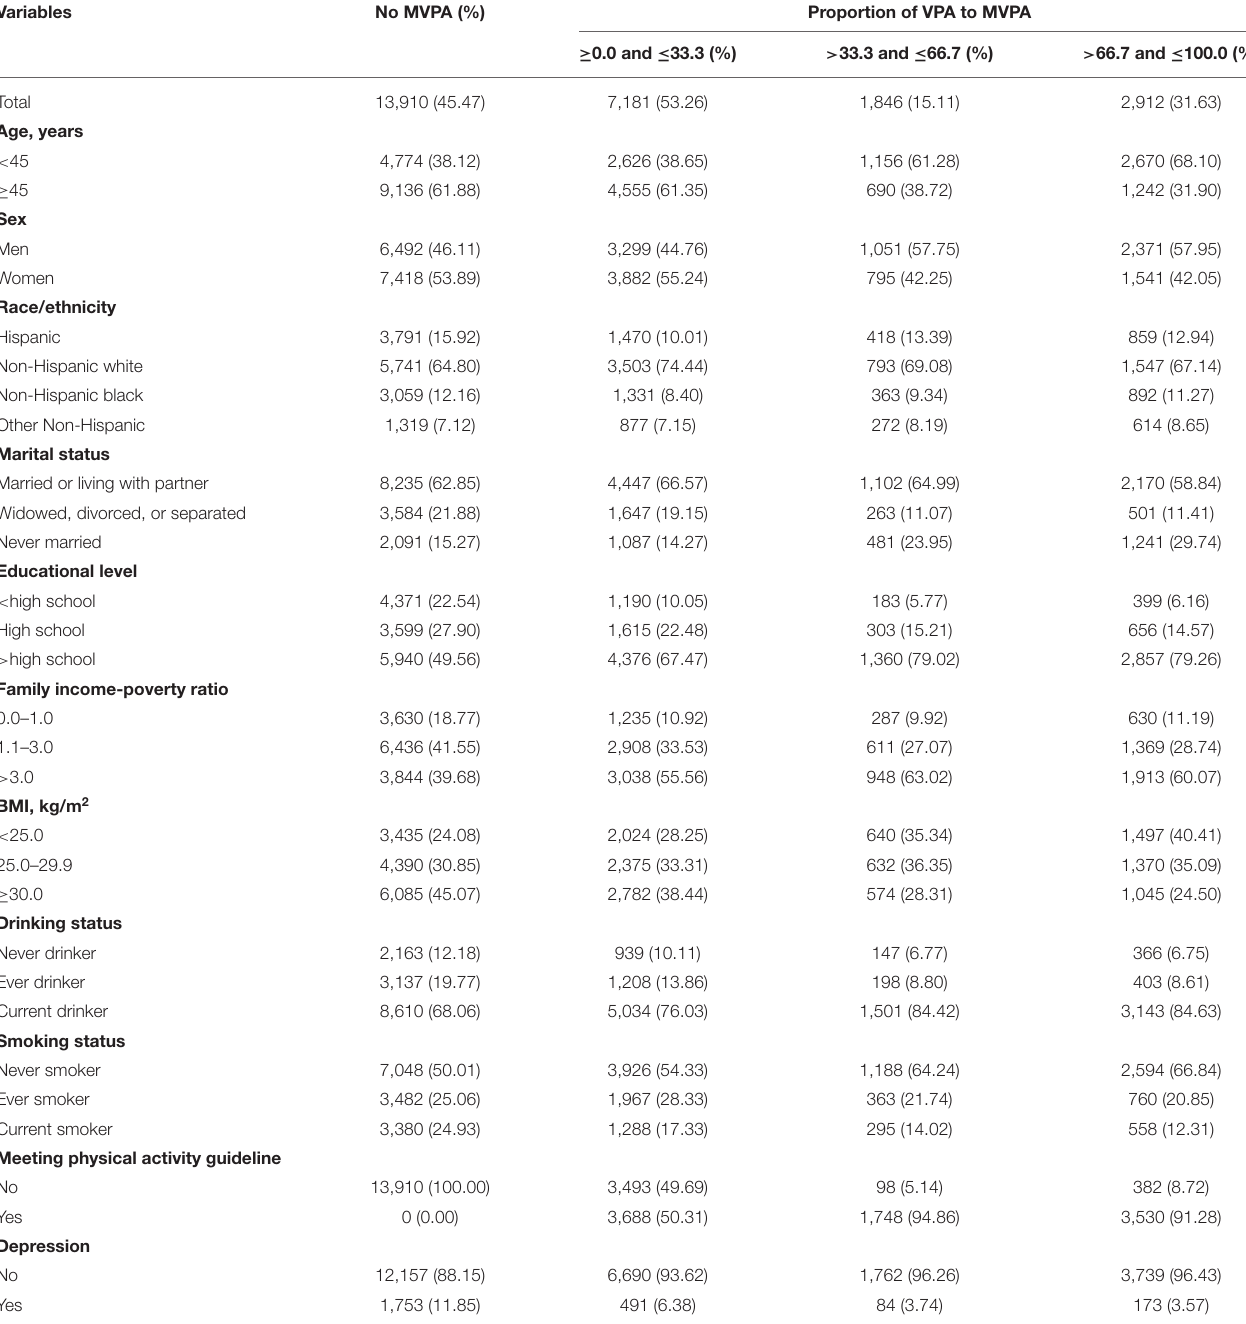
TABLE 1 | Basic characteristics of 26,849 participants in this study from NHANES 2007–2018.